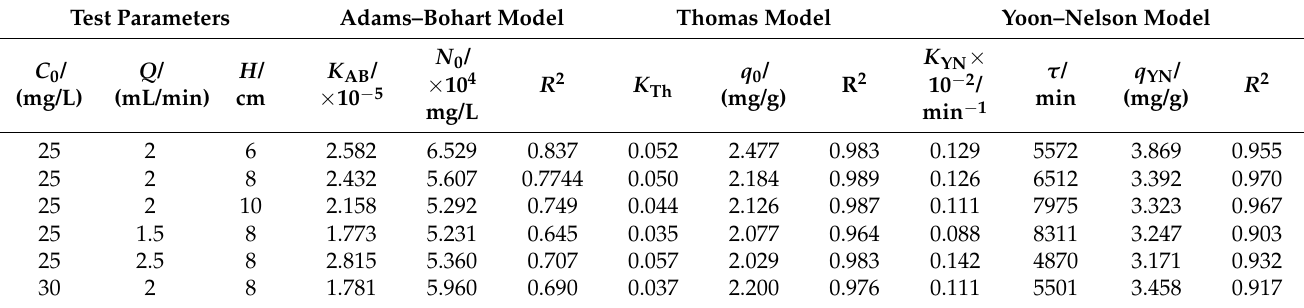
Table 3. Model parameters for the adsorption of Fe 2+ on IHA/TM.